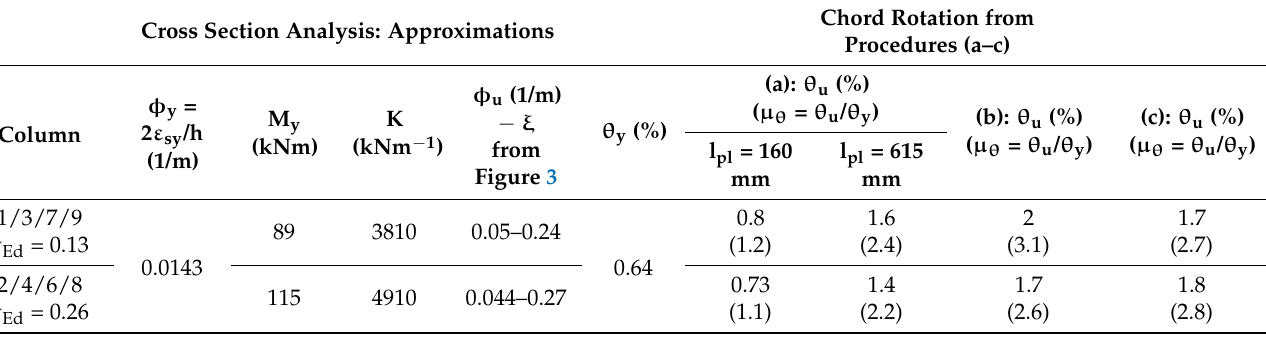
Table 1. Results from cross section analysis and rotation